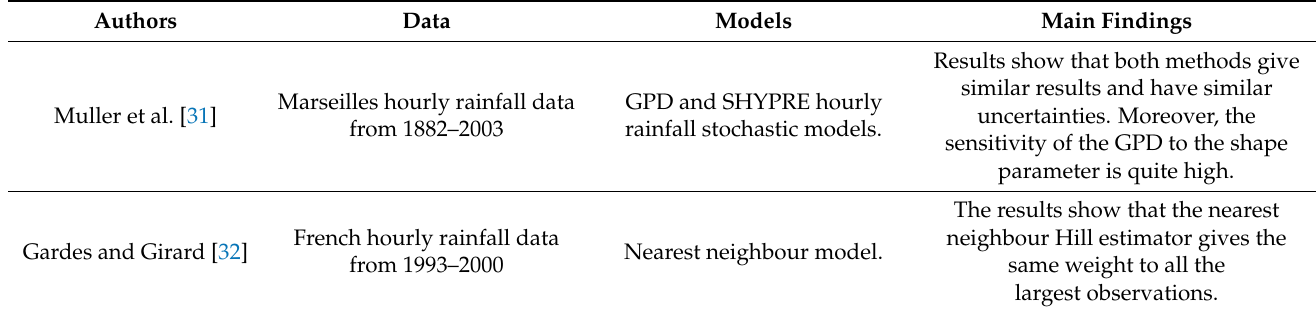
Table 1. Summary of previous studies on the modelling and estimation of extremely high quantiles. Authors Data Models Main Findings Muller et al. [31]